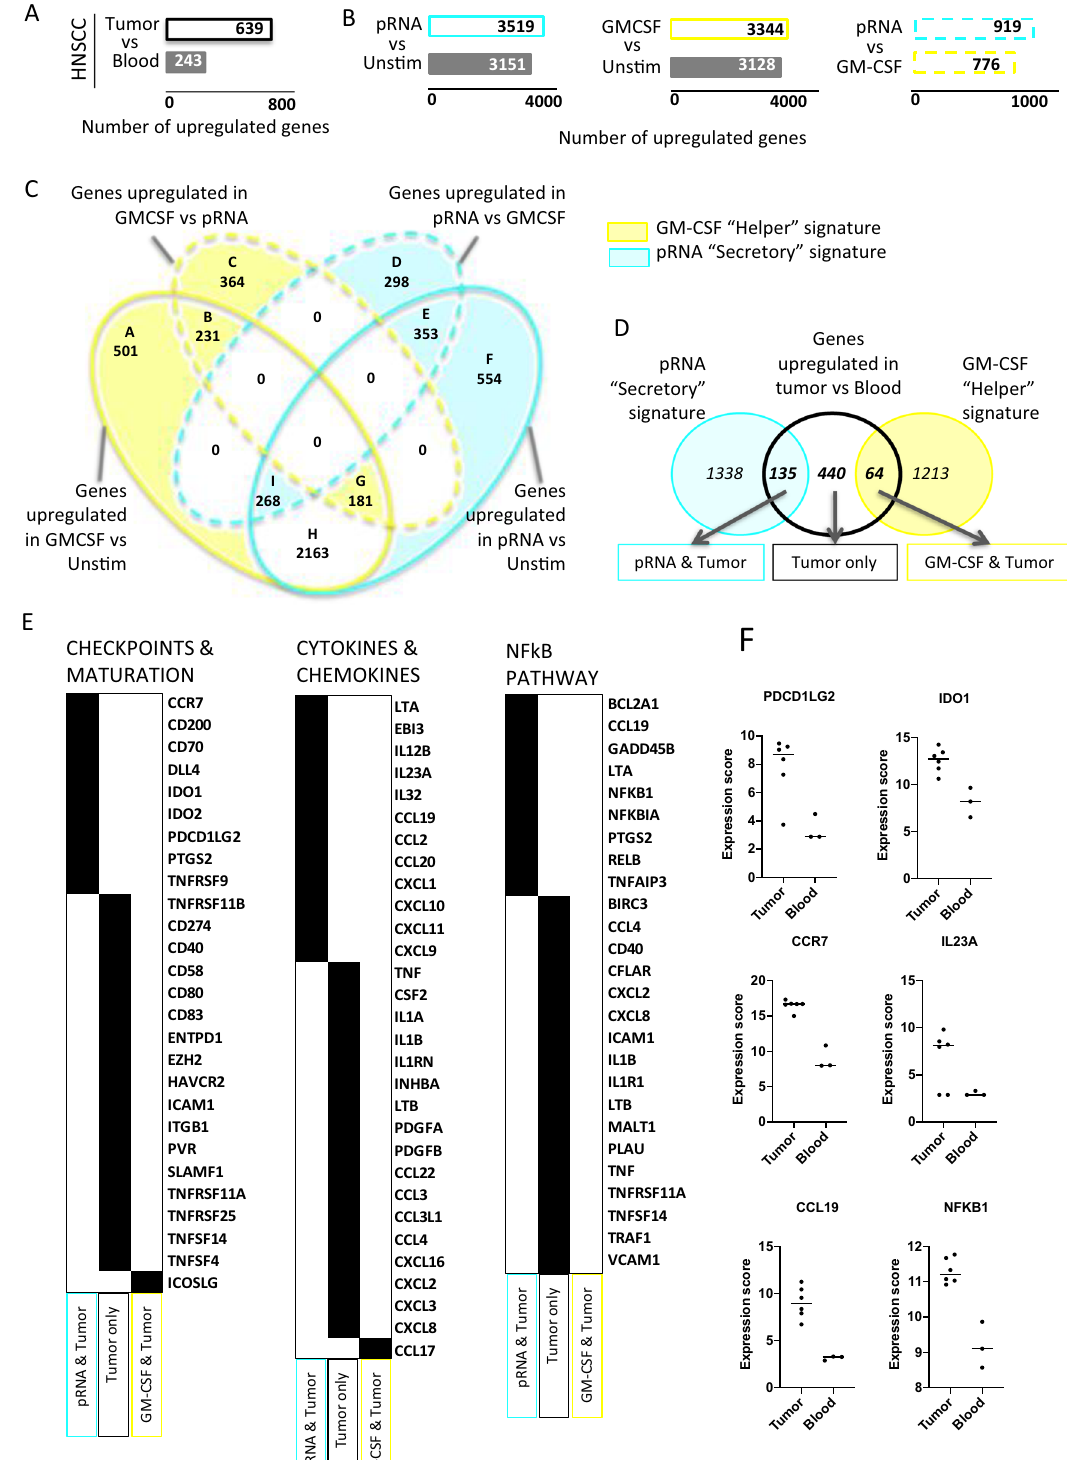
showing that a fraction of tumor cDC2 underwent a maturation that aligned with the in vitro de fi ned Secretory maturation at the transcriptomic level (Fig. 6C, Supplementary Fig. 12A). ADT con fi rmed that mmDC expressed the highest levels of PD-L1 and did not express ICOSL (Fig. 6B, Supplementary Fig. 11A, B). ADT CD1c con fi rmed that these cells are at least in part cDC2 (Fig. 6B). cDC1 may also contribute to this population of mmDC